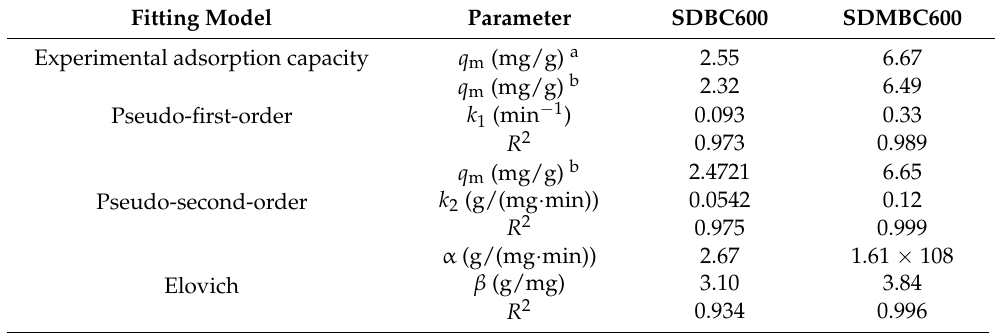
Table 1. Adsorption kinetic parameters for diuron by SDBC600 and SDMBC600.